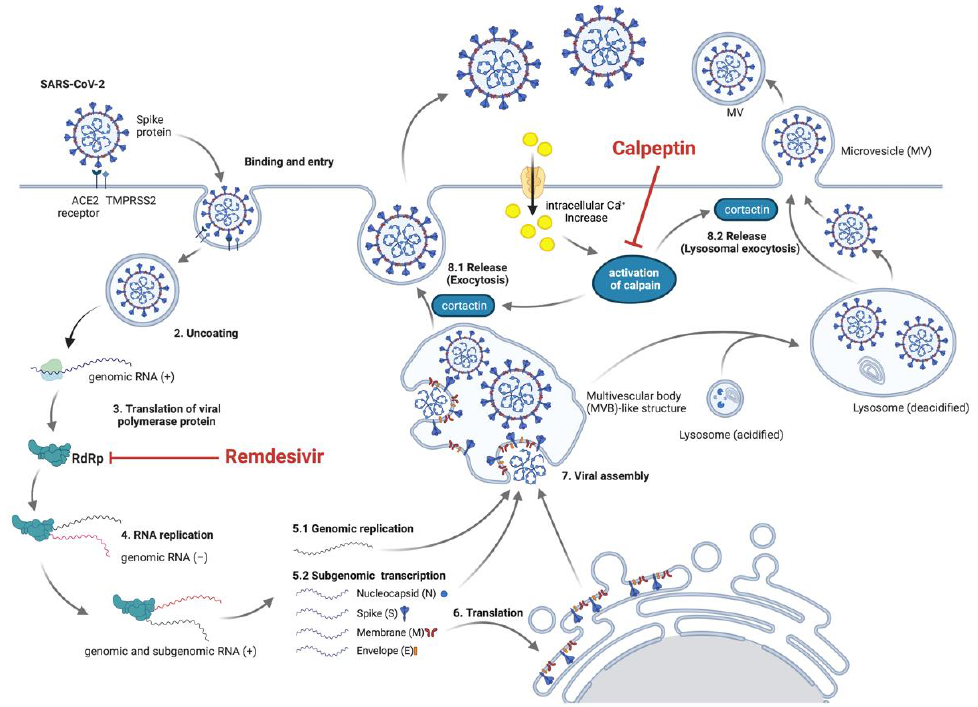
Figure 6. Proposed mechanisms of SARS-CoV-2 inhibition by remdesivir and calpeptin combination. Remdesivir, a virus- Remdesivir, a virus-targeting drug, inhibits RNA-dependent RNA polymerase (RdRp), leading to targeting drug, inhibits RNA-dependent RNA polymerase (RdRp), leading to the inhibition of SARS-CoV-2 replication. the inhibition of SARS-CoV-2 replication. Calpeptin, a host-targeting compound, suppresses the Calpeptin, a host-targeting compound, suppresses the viral release via inhibiting EV trafficking and shedding microvesi- cles, resulting in the inhibition of SARS-CoV-2 production and release. This figure was created with BioRender.com (ac- cessed on 13 August 2021). 13 August